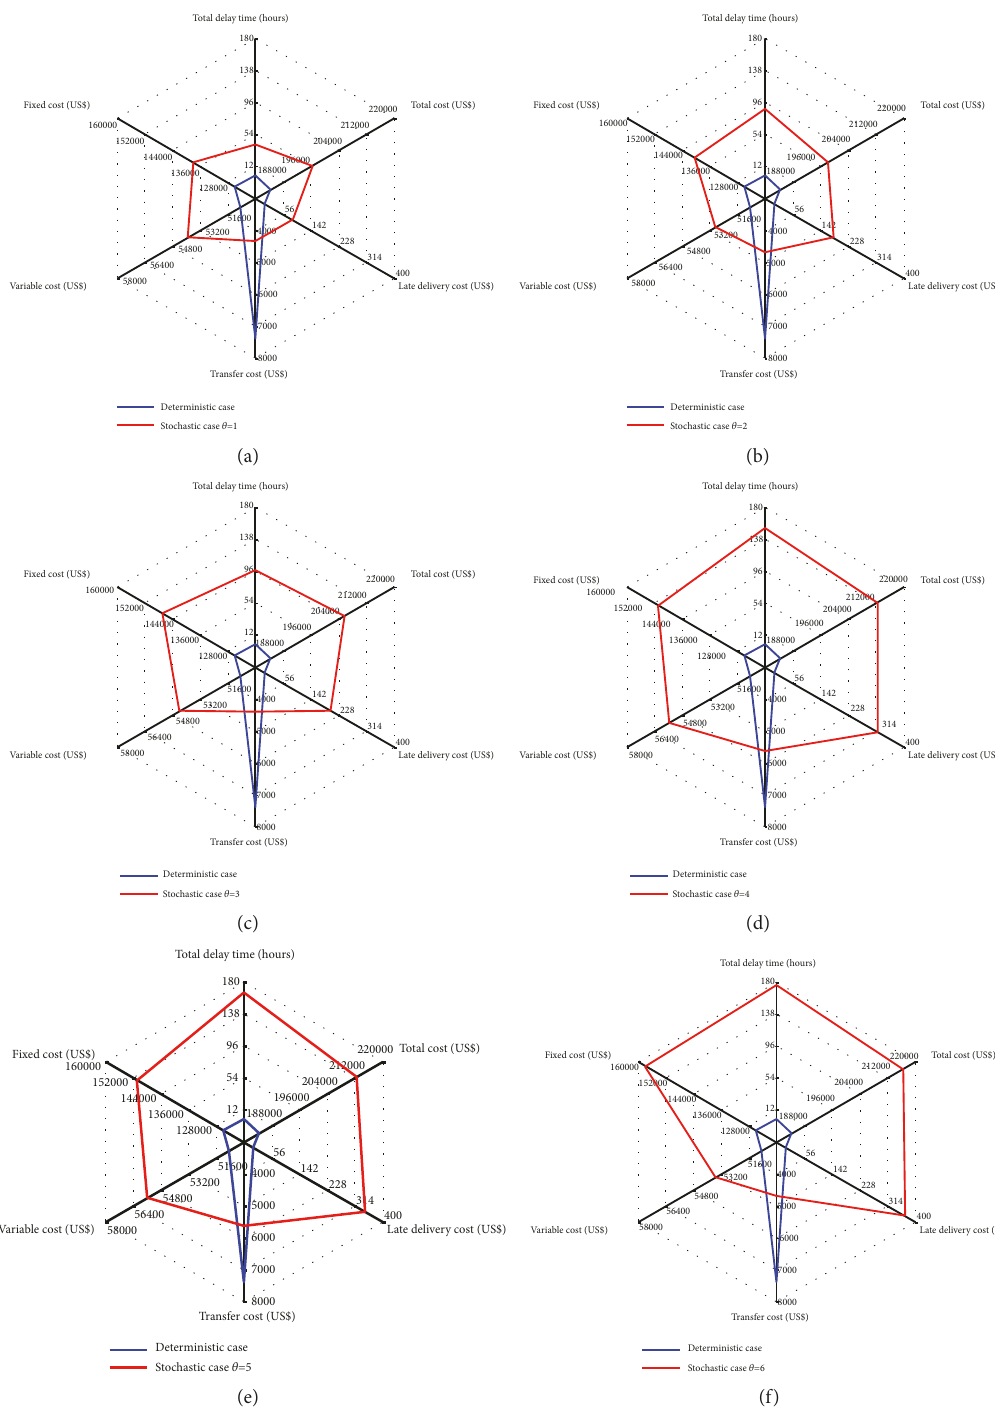
Figure 6: The costs under different multiplier 𝜃 . (a) 𝜃 = 1 . (b) 𝜃 = 2 . (c) 𝜃 = 3 . (d) 𝜃 = 4 . (e) 𝜃 = 5 . (f) 𝜃 = 6 .